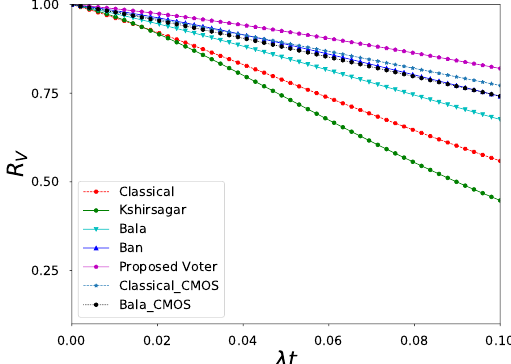
Figure 8. Reliability curves for